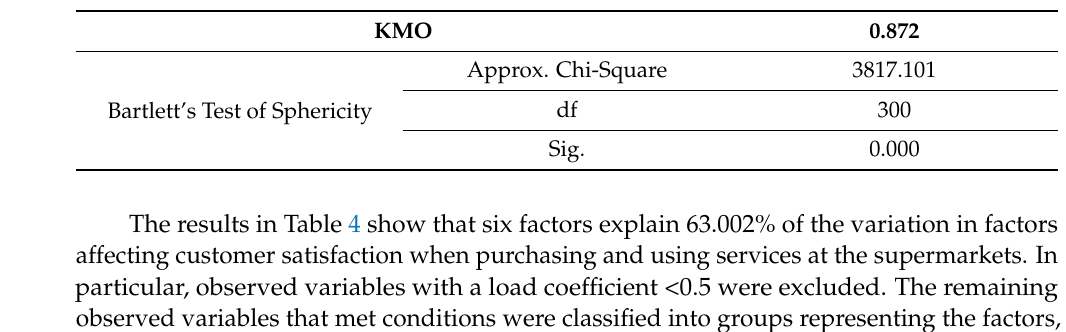
Table 3. KMO and Bartlett’s test (Independent variable).